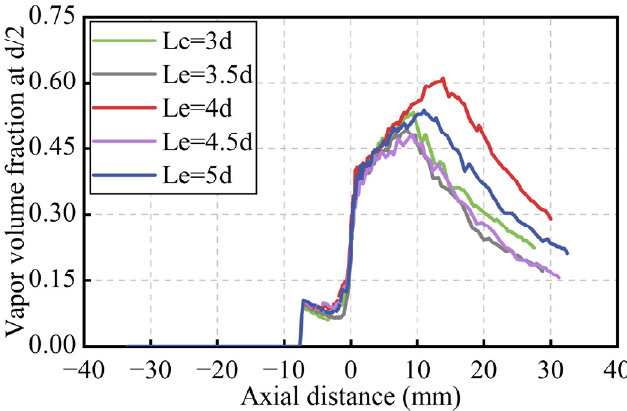
Figure 23. Effect of Le on the cavitation.